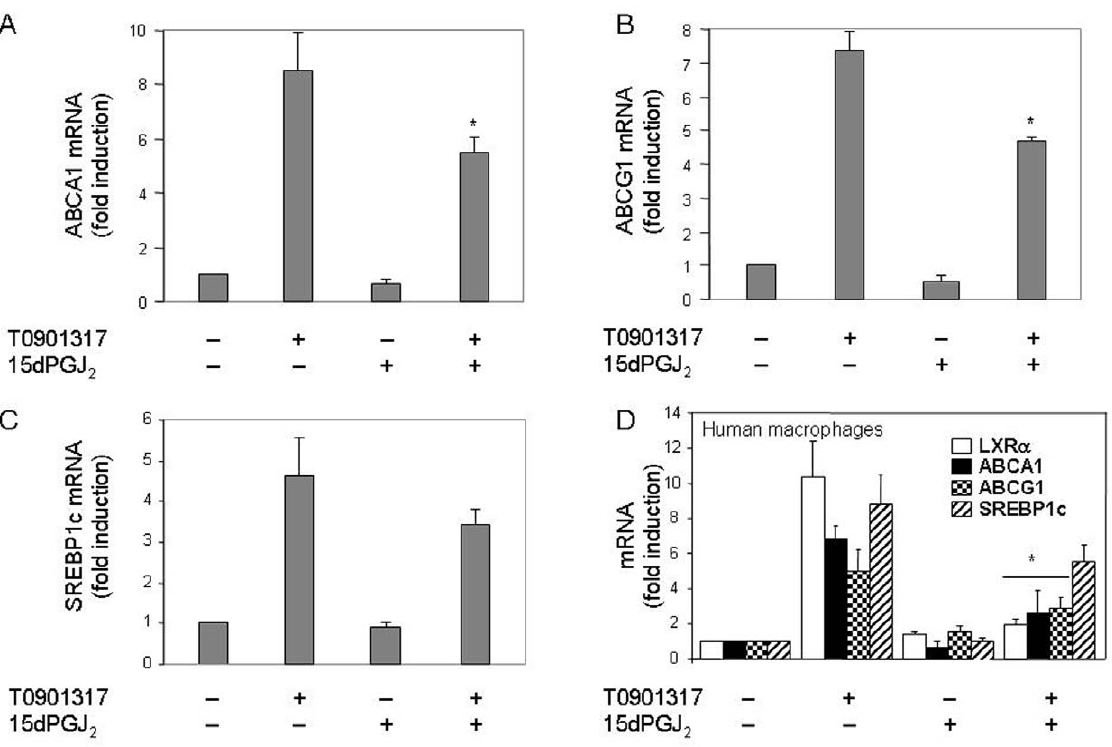
Figure 2. 15dPGJ 2 prevents T0901317-induced ABCA1, ABCG1 and SREBP1c mRNA expression in human neutrophils and macrophages. Neutrophils (A-C) or macrophages (D) were preincubated at 37 u C with or without 10 m M 15dPGJ 2 for 1 h, and thereafter they were stimulated or not with 1 m M T0901317 for 18 h. The levels of mRNA from the indicated genes were analyzed by real time RT-PCR. Statistical data (mean 6 SEM, n=3) were corrected for differences in b -actin mRNA levels and expressed as fold induction. * P , 0.01 for T0901317-stimulated, 15dPGJ 2 -treated versus -untreated.